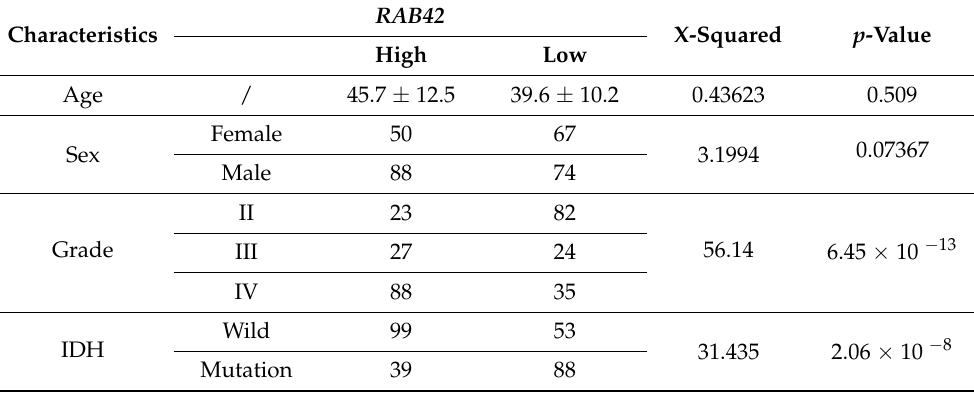
Table 2. Clinicopathological characteristics of GBM patients from CGGA